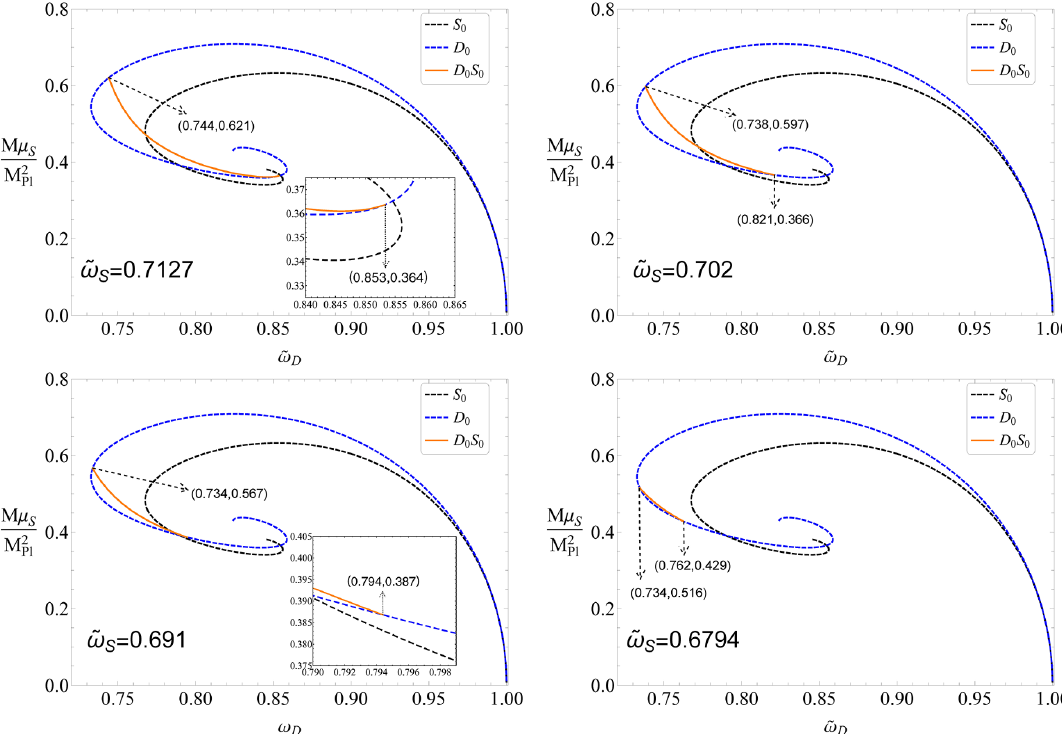
Figure 10. The ADM mass M of the DBSs as a function of the nonsynchronized frequency ˜ ω D for ˜ ω S = 0 . 7127 , 0 . 702 , 0 . 691 , 0 . 6794 . The black dashed line represents the S 0 state solutions, the blue dashed line represents the D 0 state solutions, and the orange line denote the coexisting state D 0 S 0 . All solutions have ˜ µ D = ˜ µ S = 1 .